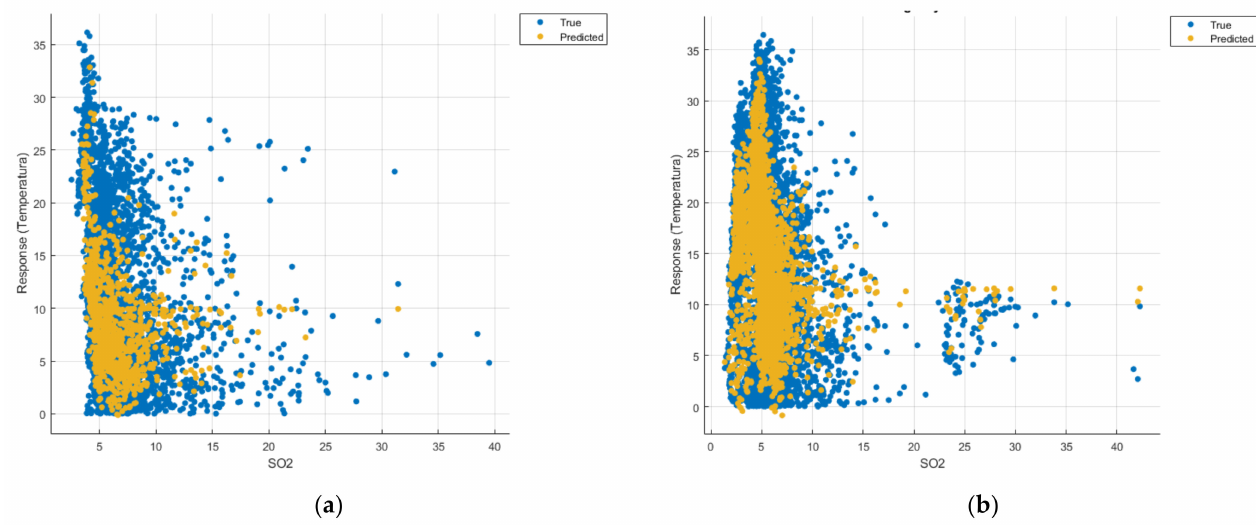
Figure 15. Prediction considering only SO 2 —Fine Gaussian SVM. ( a ) March 2019–February 2020, ( b ) March 2020– February